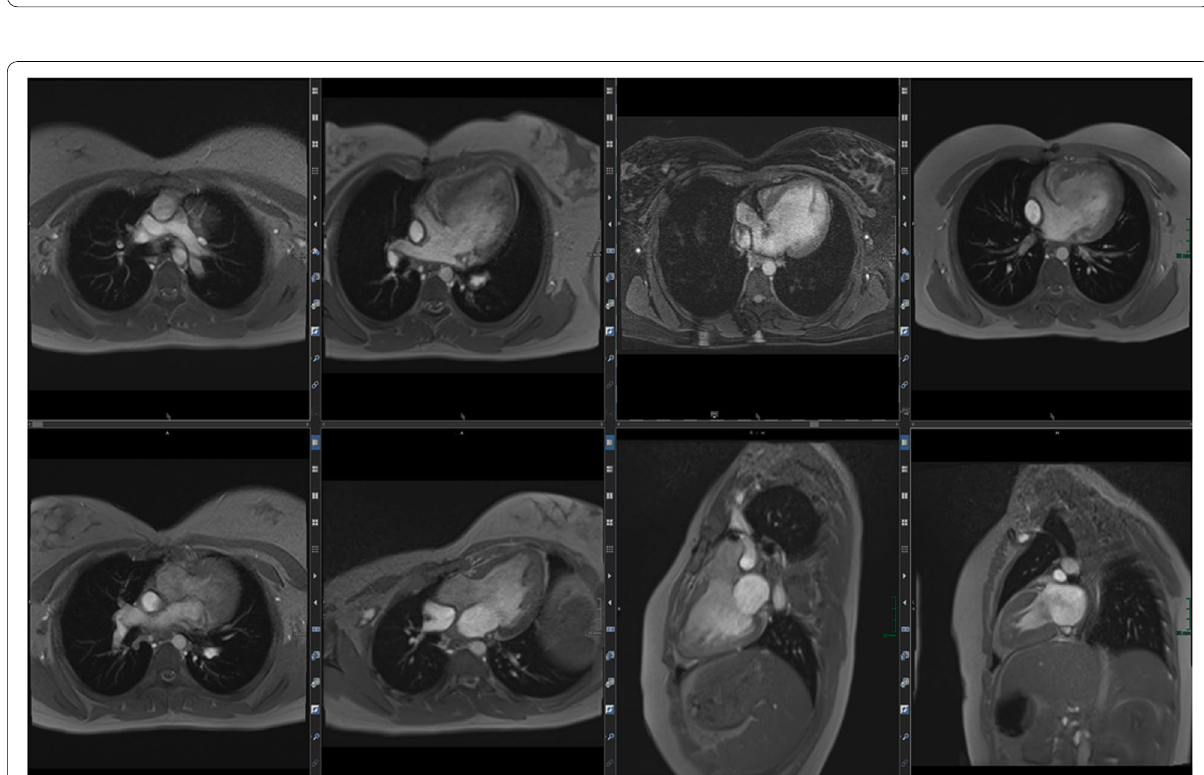
Fig. 10 (2D flow): left–right shunting due to the ASD. Flow is depicted morphologically (“magnitude images,” left lower row) and hemodynamically (“phase-images, left upper row and middle lower row”); the latter allows a quantitative assessment of velocities, directions, and flow profiles (upper row in the middle)